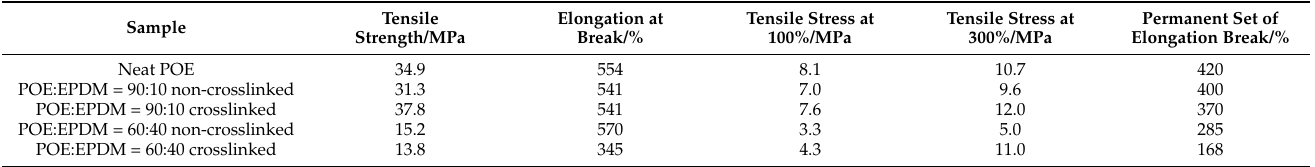
Table 3. Mechanical properties of neat POE and the POE/EPDM